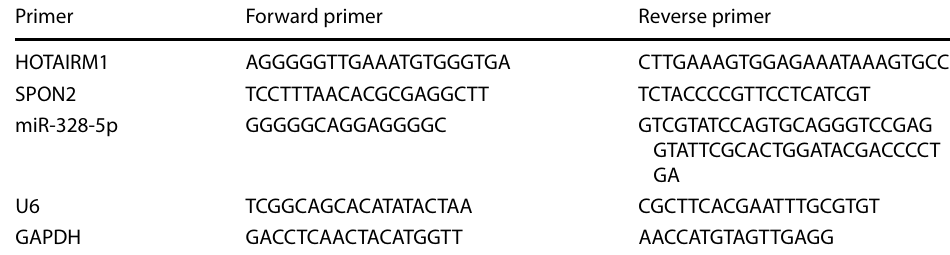
Table 1 The sequences of oligonucleotides and primers